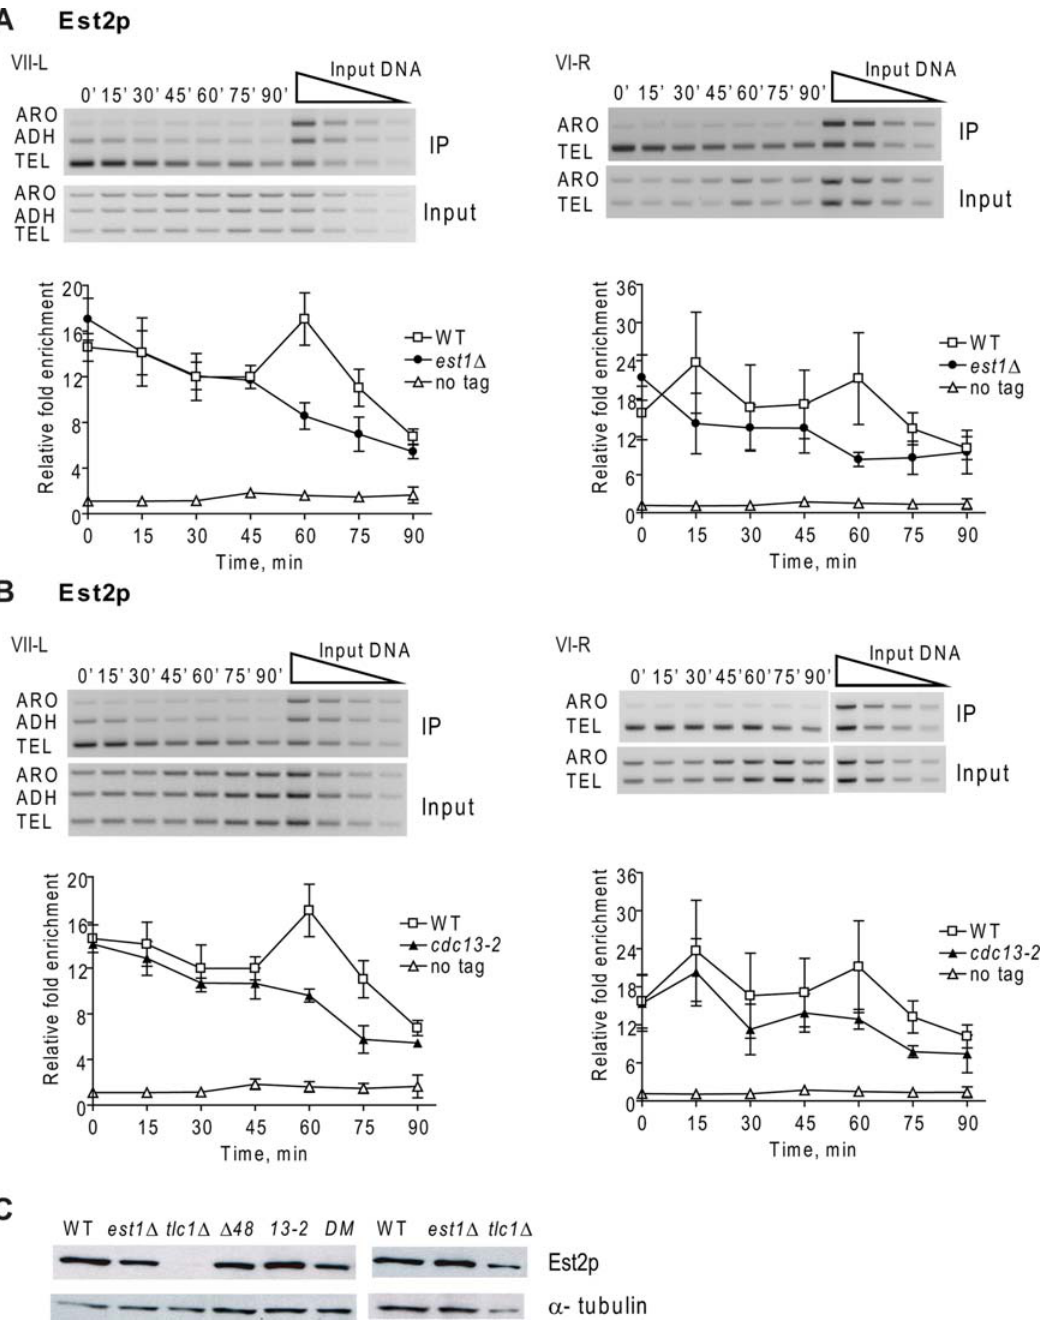
Figure 1. Est2p telomere binding in late S/G2 phase is reduced in est1 D and cdc13-2 cells. Cells expressing Est2-G8-Myc or lacking a Myc- tagged protein (no tag) were arrested in G1 phase. After release from the arrest, cells were grown at 24 u C and samples taken at 15 min intervals for FACS and chromatin immuno-precipitation (ChIP). After DNA purification, PCR amplification was carried out with telomeric (TEL), subtelomeric (ADH), and non-telomeric (ARO) primers on DNA from immuno-precipitates (IP) or whole cell lysates (Input). Two-fold serial dilutions of input DNA established the linear range of the reactions (Input, top right). In this and subsequent figures, the agarose gels are representative data from mutant strains. For each time point, binding is expressed as the relative fold enrichment of TEL over ARO signal after normalization to input DNA. Error bars are 6 1 standard deviations from $ 3 independent synchronies. A. Est2p binding to VII-L (left) and VI-R (right) telomeres in synchronous est1 D (black circles) versus WT (white squares), or untagged (white triangles) cells. The values for Est2p binding to the VII-L telomere were not significantly different in WT versus est1 D cells (P values . 0.05), except at 60 (P value of 0.002), 75 (P=0.02) and 90 (P=0.04) minutes. Est2p binding to the VI-R telomere in WT versus est1 D cells was significantly different only at 60 (P=0.001) and 75 (P=0.01) min. B. Est2p binding to VII-L (left) and VI-R (right) telomeres in synchronous cdc13-2 (black triangles) versus WT (white squares), or untagged (white triangles) cells. Est2p binding to the VII-L telomere were significantly different in WT versus cdc13-2 cells only at 60 (P=0.01) and 75 (P=0.02) minutes. At VI-R, binding was significantly different only at 75 minutes (P=0.005) C. Western analyses of Est2p-G8-Myc or a -tubulin levels in extracts from WT and mutant strains with duplicate extracts prepared from independent colonies. The lanes labeled D 48 are from tlc1 D 48 cells; 13-2 is cdc13-2 ; DM is double mutant tlc1 D 48 cdc13-2 . Est2p-G8- Myc in lane 3 ( tlc1 D ) was detectable upon longer exposure; see last lane that has protein sample from another tlc1 D isolate and Figure 4C. doi:10.1371/journal.pgen.1000236.g001 PLoS Genetics |